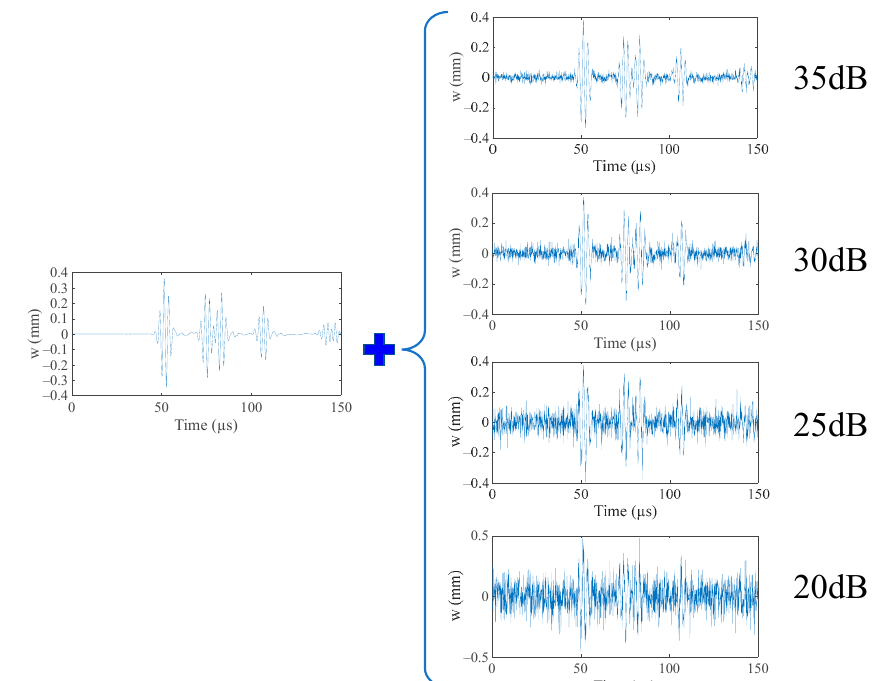
Figure 4. Effect of Gaussian white noise at different decibels on the initial signal. Four kinds of white noise are added ten times, respectively into the signal received by each receiving point. Therefore, 40 specimens can be acquired by one operation for each area, and in the nine areas shown in Figure 5, a total of 360 specimens can be obtained. The time of arrival of the first wave packet is extracted for all samples, in this way we can obtain training set data with large variability. We use the time of arrival corresponding to the eight receiving points as the input of the neural network, and the corresponding area number as the output of the model.